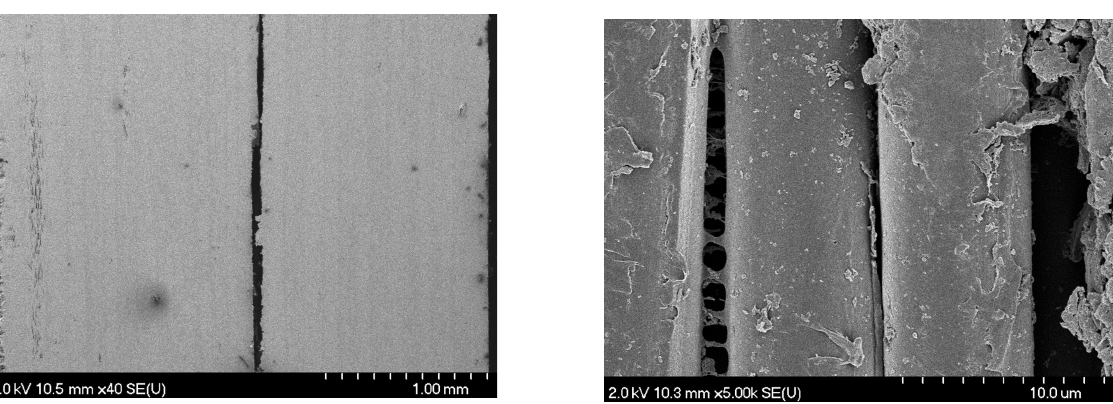
Figure 17: Presence of large defects in non-autoclave-treated sample taken from truncated cone #